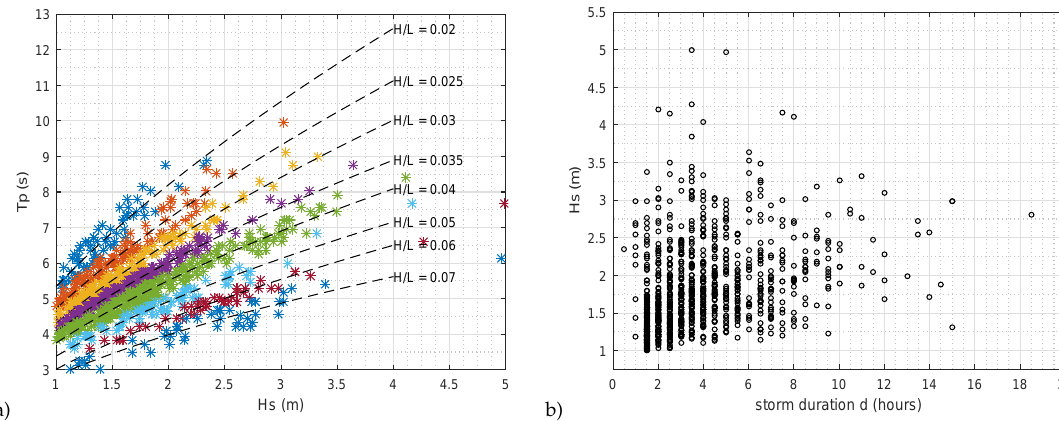
Figure 7. ( a ) Hs , Tp and steepness Hs / L correlation; and ( b ) storm duration d vs. Hs .